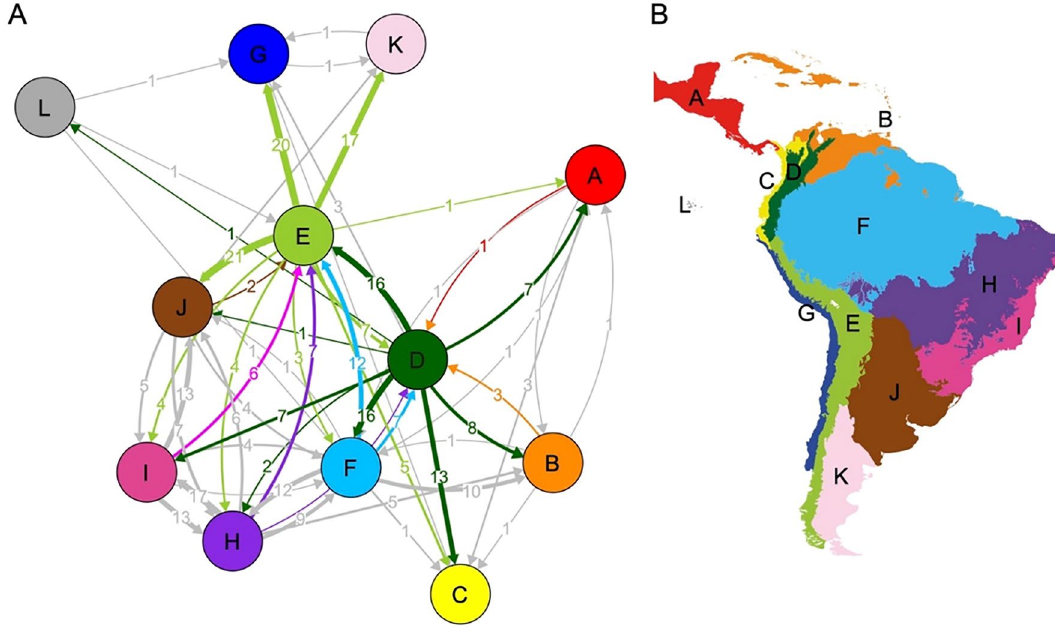
Figure 4. Estimated dispersal events among regions under the Dispersal-Extinction-Cladogenesis model implemented in BioGeoBEARS ( A ). Arrows indicate the direction and number of dispersal events, with line thickness proportional to the number of events. The position of the circles in the layout reflects the biotic connection among regions. Dispersal events out and into the Andes (Northern and Central-Southern) are highlighted in their respective color region ( B ). Interchange among non-Andean regions is shown in grey. See figure legend 3 for the names and detail of the biogeographic regions.